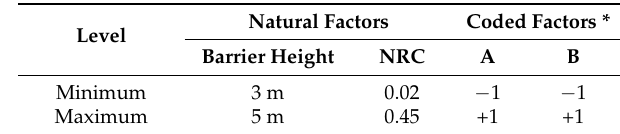
Table 5. Coded levels of the factors.